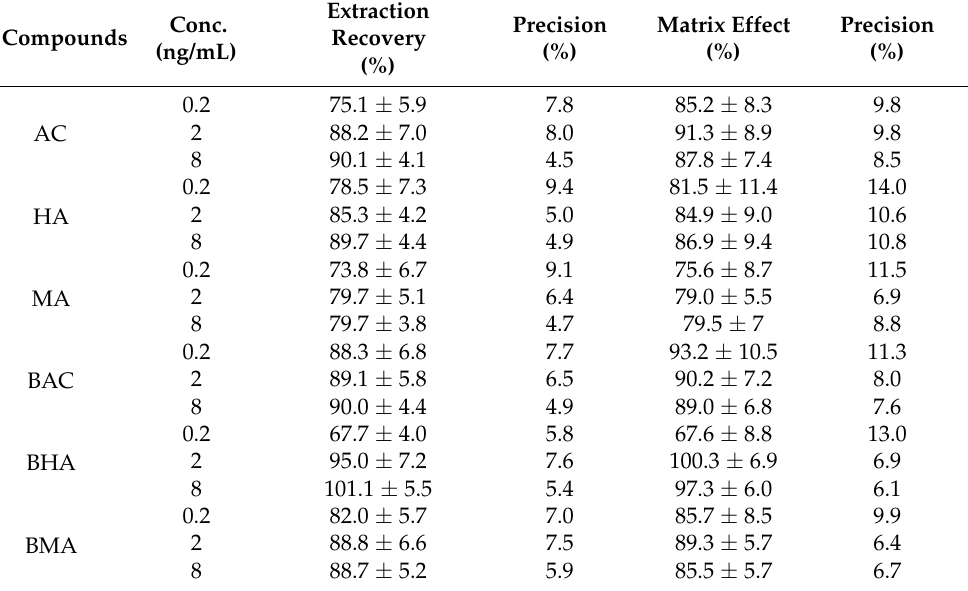
Table 4. Extraction recovery and matrix effect of the developed methods ( n = 6). Conc. Compounds (ng/mL)